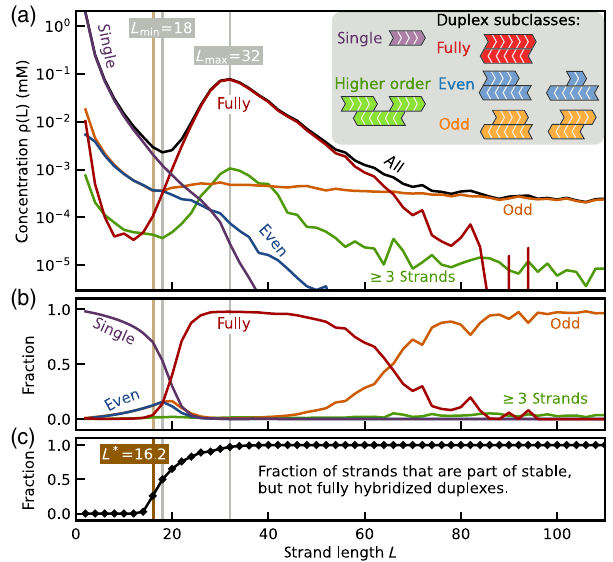
FIG. 4. (a) Partitioning the contributions of the different sub- groups to the strand-length distribution reveals the dominant configurations: Short strands are mostly single stranded. Strands with lengths around the peaks are in the persistent fully hybridized zero-parity configuration. In the dimer-only model, odd duplexes never reach a fully hybridized state and cause the long tail of the distribution. (b) The probability of different complex types conditioned on strand length. (c) The probability that a duplex with nonzero parity is stable conditioned on strand length. Around L ¼ L (cid:1) [cf. Eq. (13)] this probability increases rapidly.